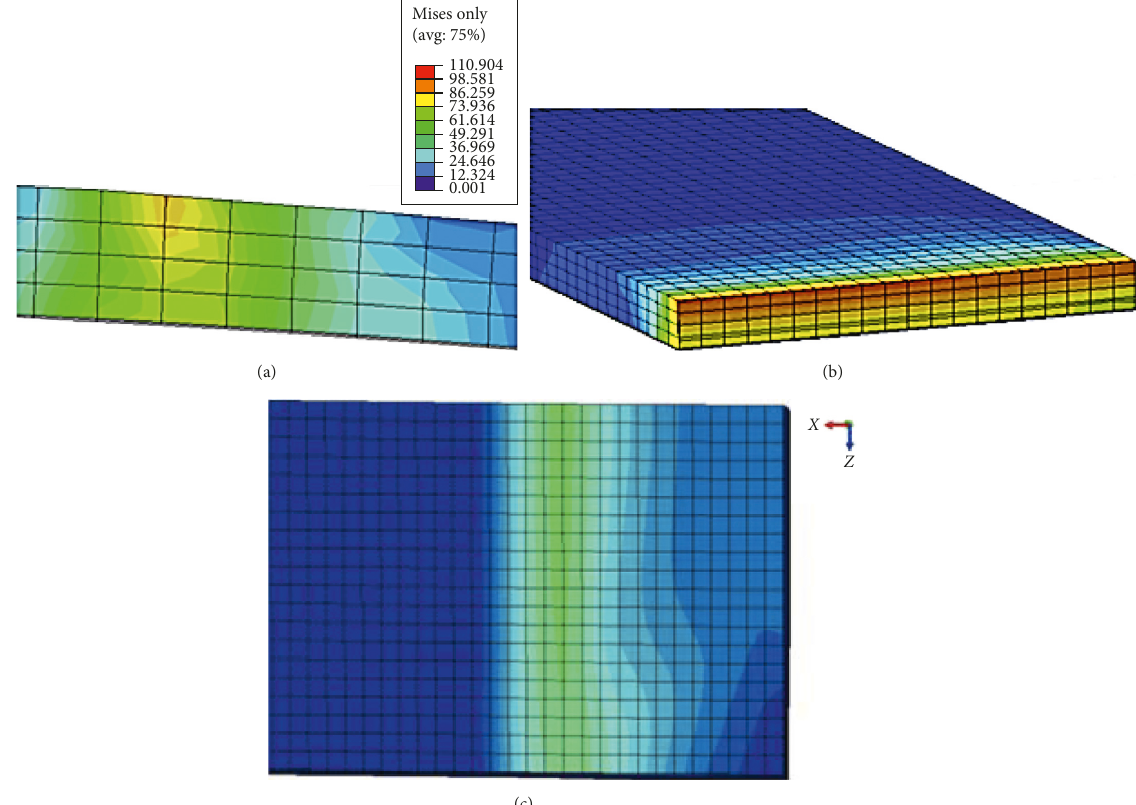
Figure 8: The distribution of equivalent stresses in the thermodeformation hearth (a, b) and in the zone of contact of the tape with the surface of the part (c) in the case of electrocontact surfacing with steel tape at K v